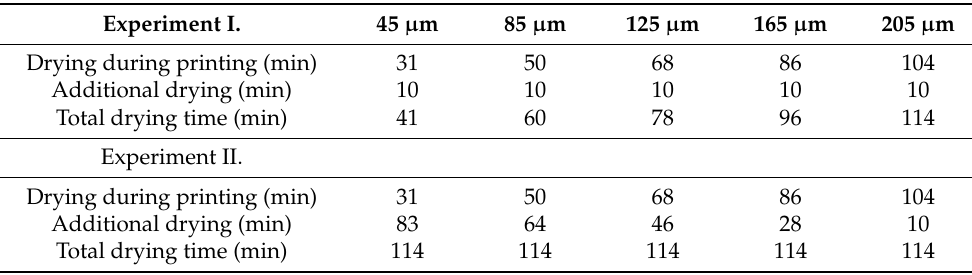
Table 2. Drying times used in the